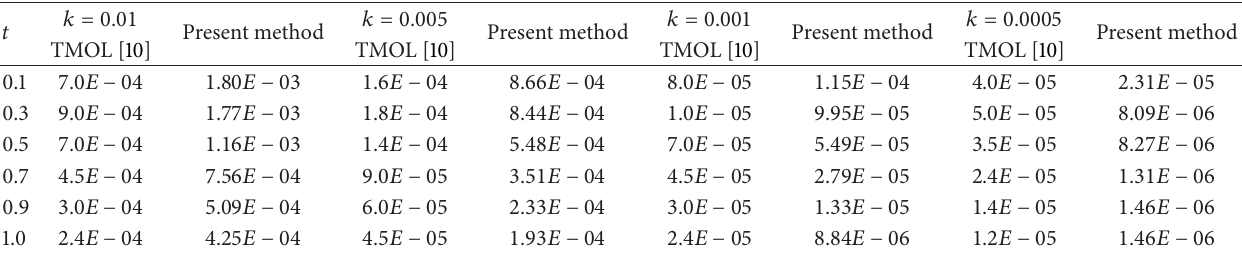
Table 4: Absolute errors for Example 2 with ℎ = 0.05 and several values of time step by present method and TMOL [10]. 𝑘 = 0.01 𝑡